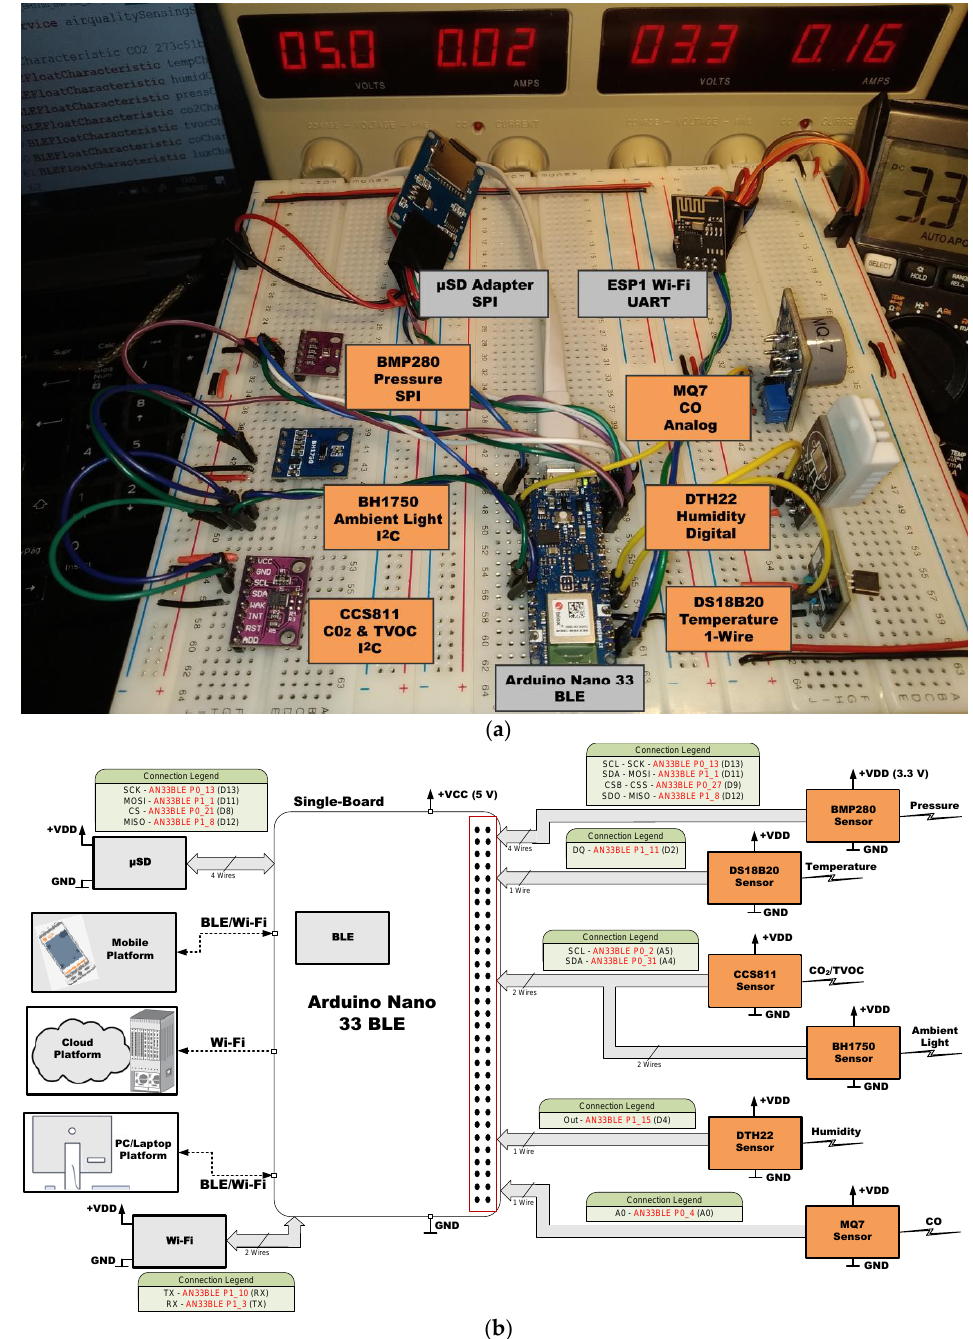
Figure 9. SBM Arduino Nano 33 BLE in experimental framework ( a ) and hardware connections ( b ) [150].